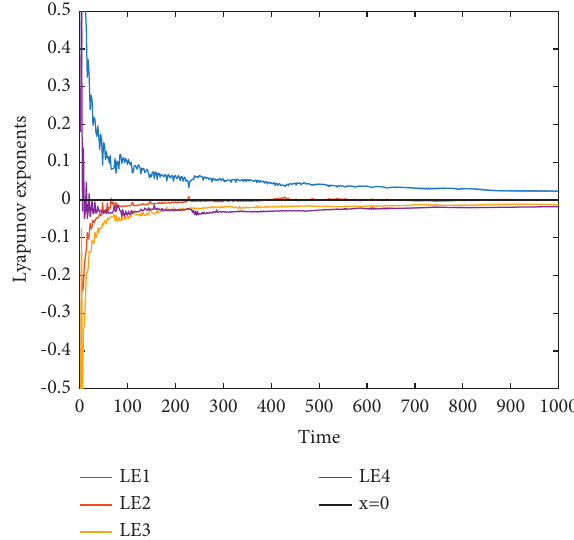
Figure 5: Lyapunov exponential of the system over